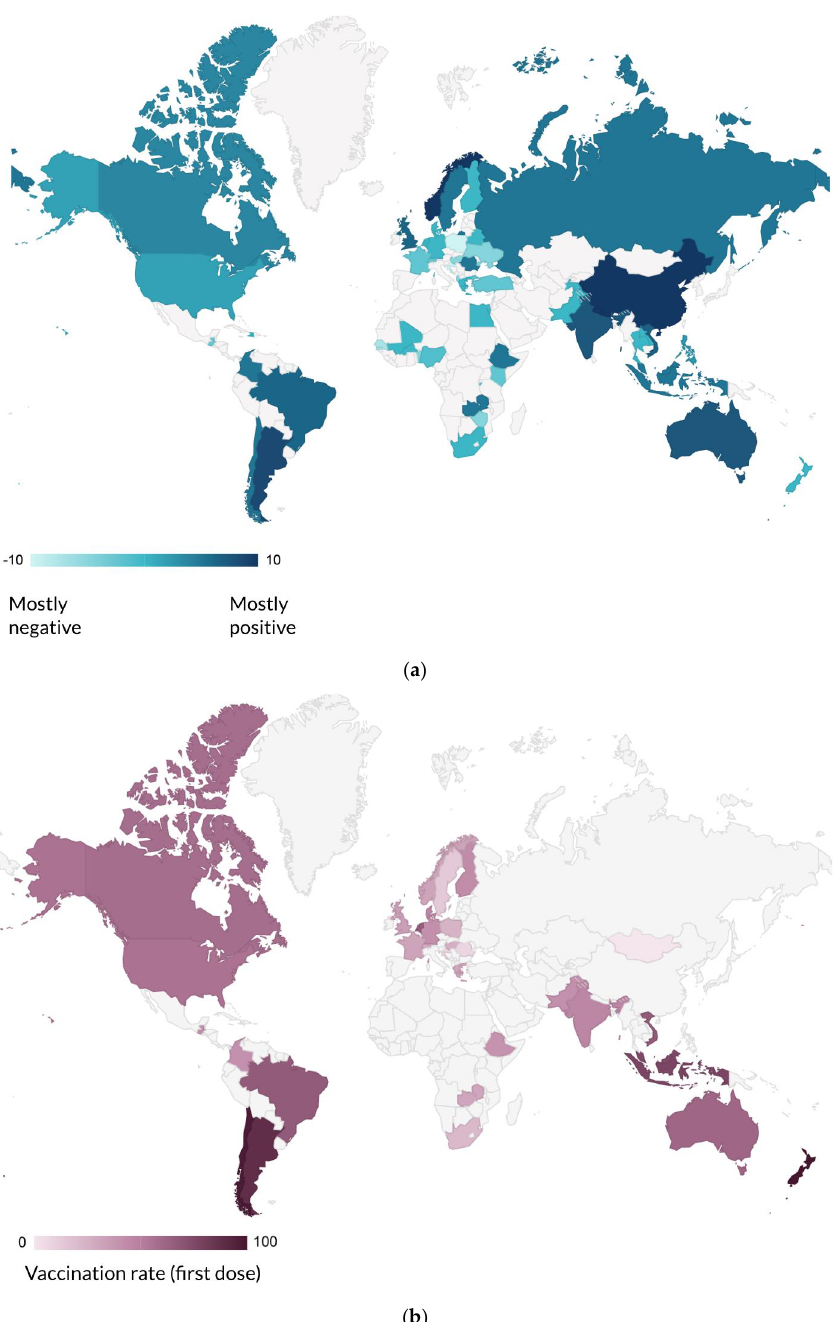
Figure 3. ( a ) Global maps depicting reported public attitude towards vaccinating children against COVID-19 and vaccination rates, April – June, 2022. ( b ) The reported vaccination rate of age-eligible children having received at least one vaccine dose.